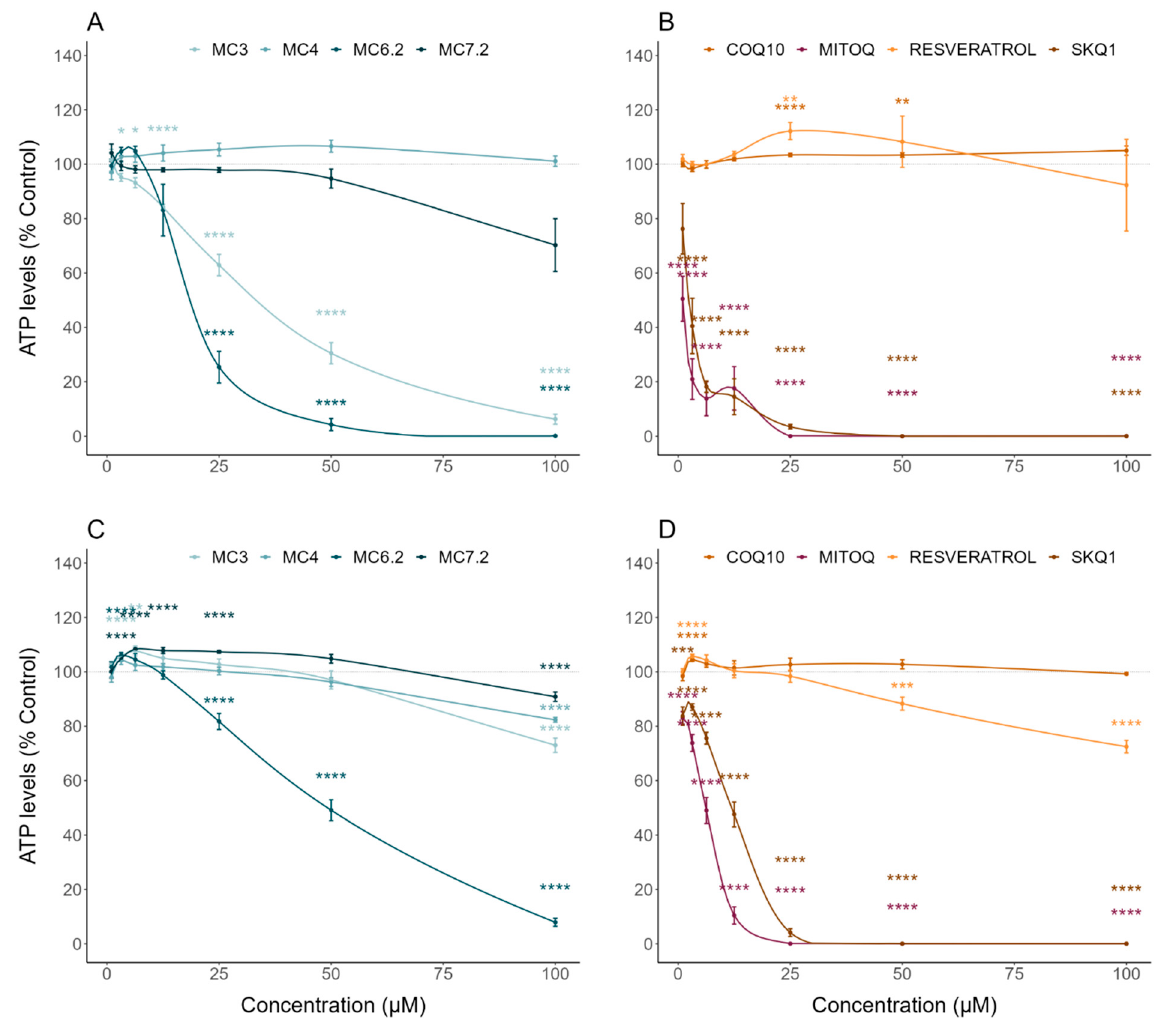
Figure 4. Effect of MitoCINs, quinone-based mitochondria-targeted and non-targeted antioxidants on ATP intracellular concentrations. Human Caucasian hepatocyte carcinoma (HepG2, ( A , B )) and differentiated human neuroblastoma (SH- SY5Y, ( C , D )) were treated with increasing concentrations of the different molecules for a period of 48 h, and intracellular ATP levels were evaluated using CellTiter-Glo ® Luminescent Cell Viability Assay. Data are the mean ± SE of three independent experiments and the results are expressed as a percentage of the control (control = 100%). Statistically significant differences between control (CTL) and treated groups were evaluated using a t -test. **** p < 0.0001, *** p < 0.001, ** p < 0.01 and * p < 0.05 compared to the respective control (CTL).